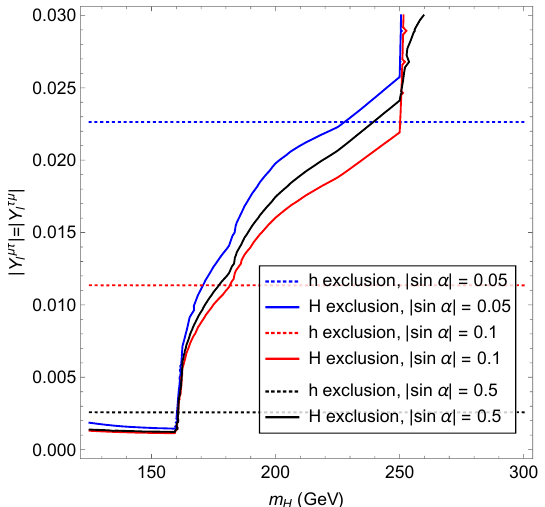
Figure 18. Projected 13 TeV with 300 fb (cid:0) 1 luminosity LHC bounds on Y (cid:22)(cid:28) of the heavy scalar mass with sin (cid:11) = 0.05, 0.1 and 0.5 respectively. The region above each curve is excluded. Here we assume (cid:21) hhH = 1, m H < 2 m A and m H < 2 m